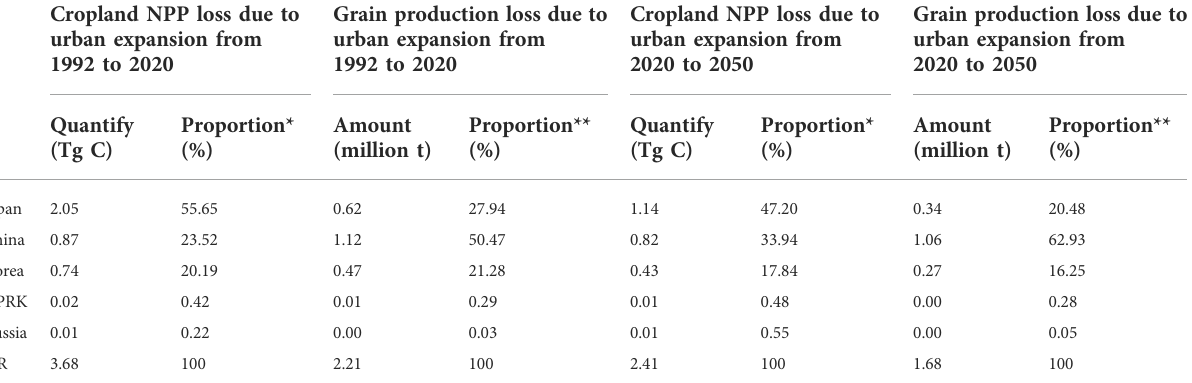
TABLE 2 Cropland NPP loss and grain production loss due to urban expansion from 1992 to